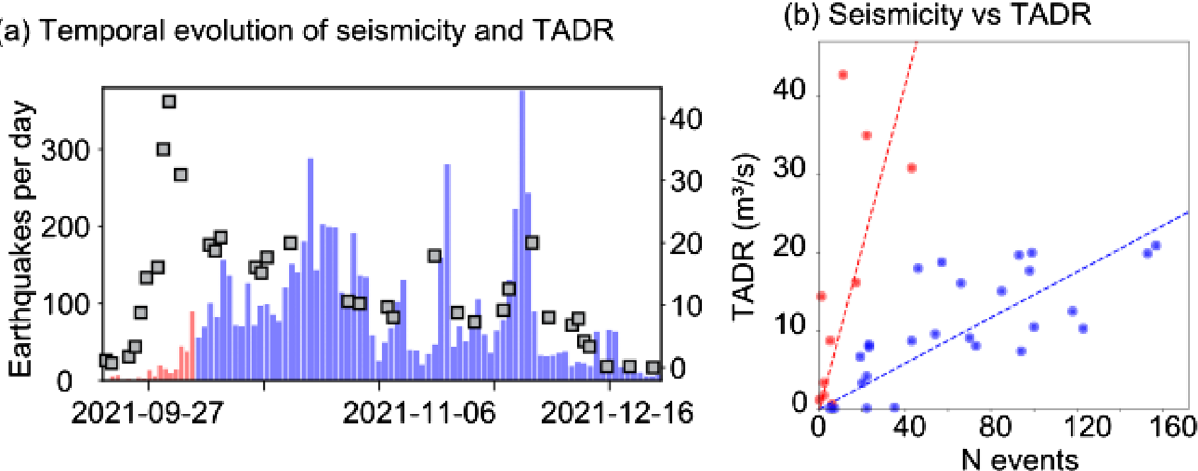
Figure 6. ( a ) Temporal evolution of seismicity and TADR. ( b ) Seismicity versus TADR. Two different trends can be observed: a diverging trend with an increase of effusion rate together with rather low seismicity (shown in red color) and a correlated trend after October 5, 2021 (shown in blue color). Pearson correlation-coefficients for the two time periods are 0.65 (red) and 0.73 (blue),